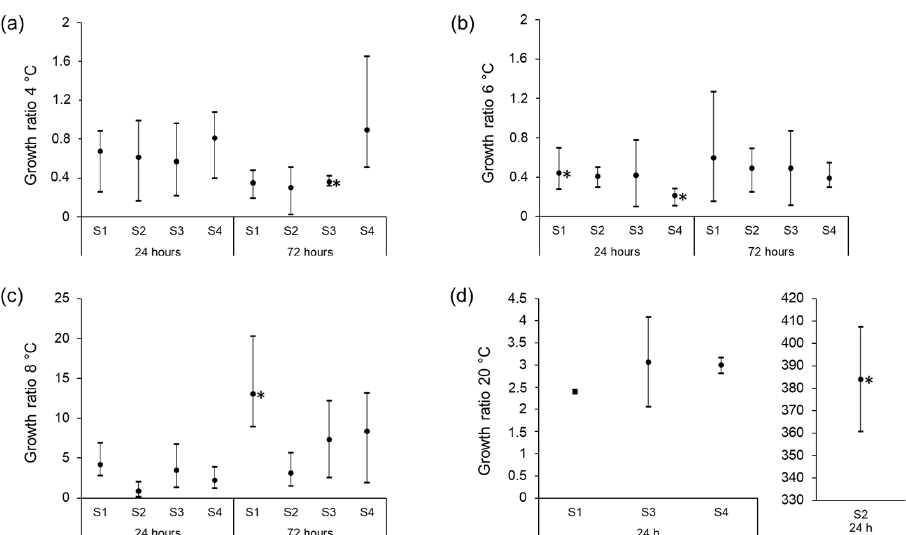
Figure 3. Chart showing the minimum, maximum, and average of growth ratios for STEC isolates S1, S2, S3, and S4 in unpasteurized milk at 4 °C ( a ), 6 °C ( b ), 8 °C ( c ), and 20 °C ( d ). Growth ratios below 1 indicate cell death while a growth ratio above 1 indicates growth. Asterisks represent statistical differences from pairwise comparisons between inoculation point and 24 or 72 h using two-tailed paired Student’s t tests (* p ≤ 0.05).